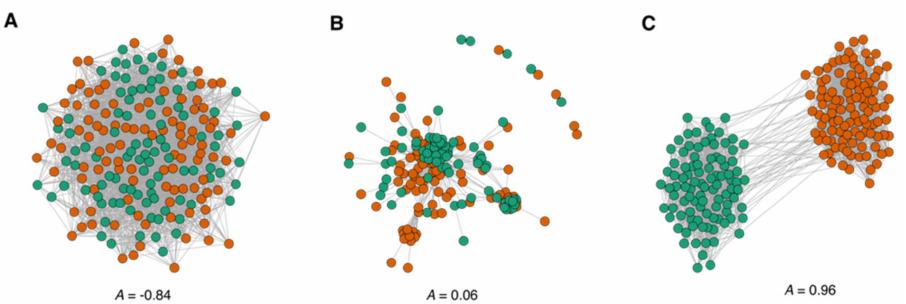
Figure 4. Assortative mixing of the drug similarity network. Nodes of different types are represented in green and orange circles ( A ) Assortative mixing of a network model in the low end of the assor- tativity range. ( B ) Assortative mixing of the drug similarity network. ( C ) Assortativity mixing of a network model in the upper end of the assortativity